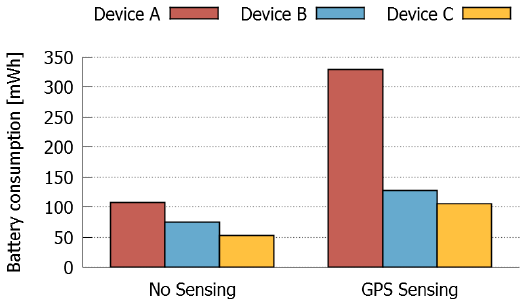
Figure 14. Sensing costs for different devices.